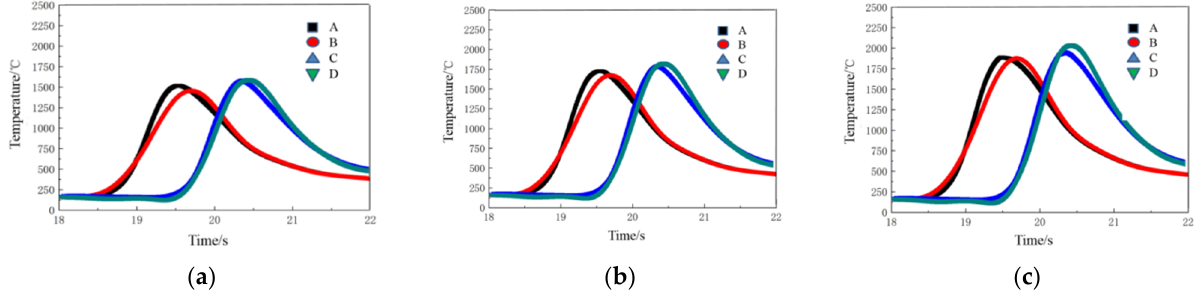
Figure 7. Temperature–time curves. ( a ) 130 A; ( b ) 160 A; ( c ) 190 A.